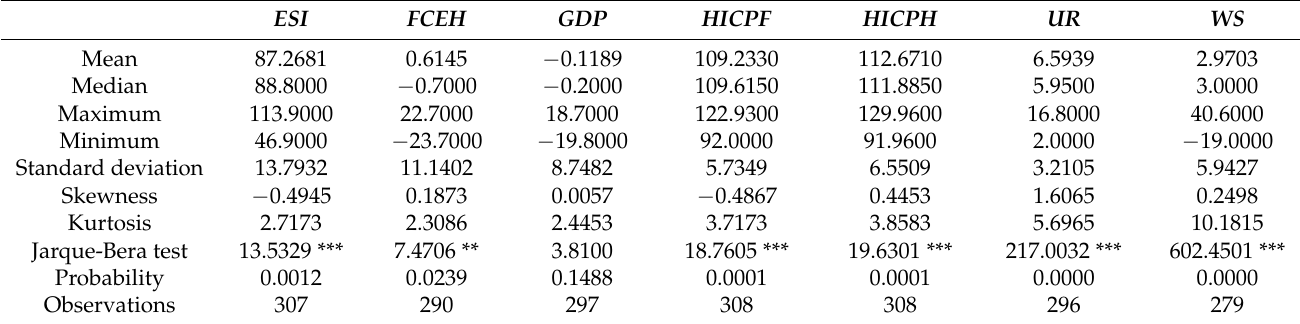
Table 1. Descriptive statistics for the variables of interest.